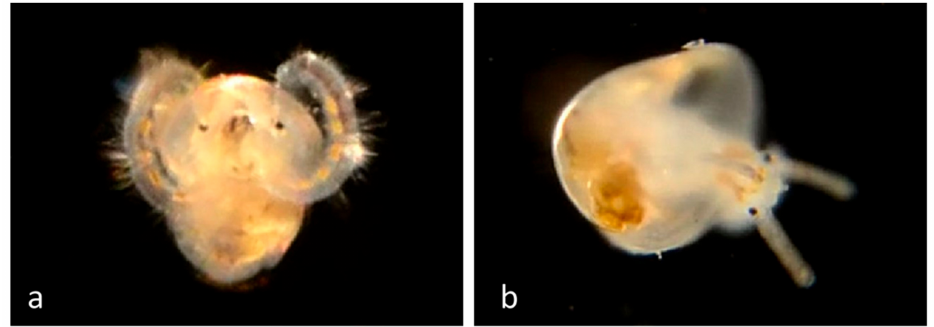
Figure 5. Family Calyptraeidae. Slipper snail , Crepidula naticarum . ( a ) Veliger CCDB-24722-H04